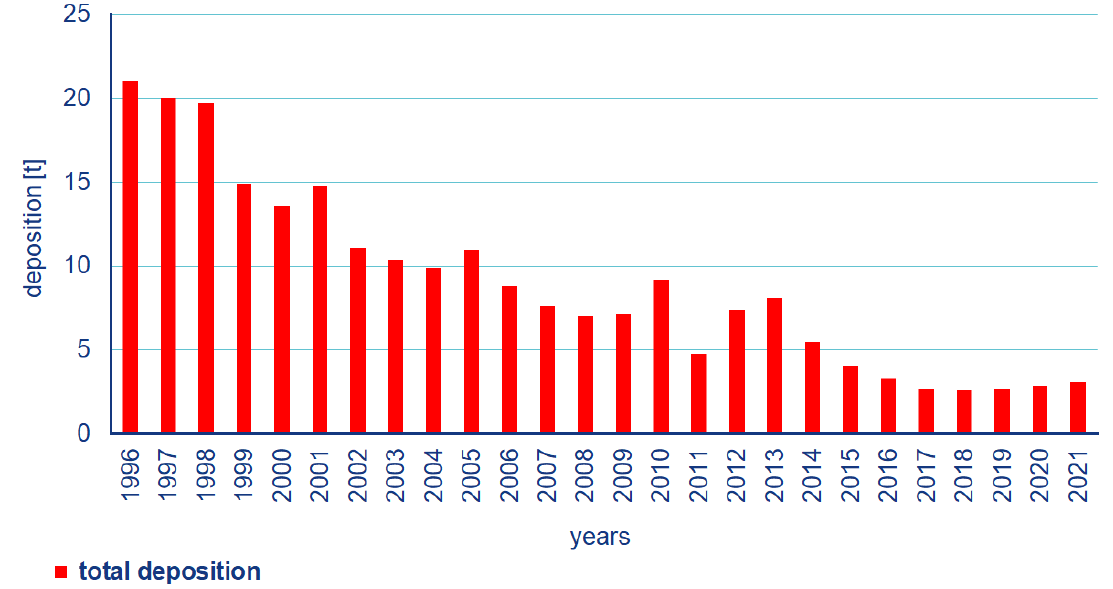
Figure 7. Estimate of annual total deposition of Cd over the entire area of the Czech Republic (78,841 km 2 ) based on data-driven geostatistic model, 1996–2021.